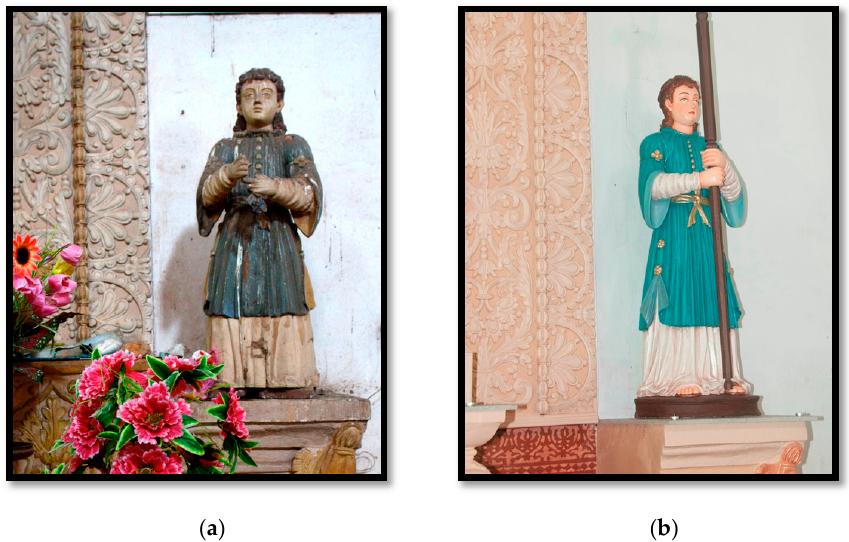
Figure 8. Polychrome teak statue on altar, Church of Santa Monica, late 16th or 17th century, Goa. ( a ) Before Restoration; ( b ) After Restoration.